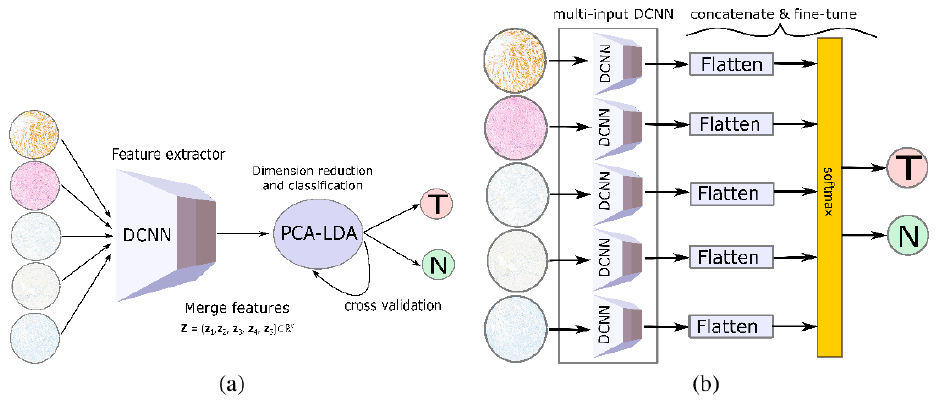
Figure 9. Data fusion approaches using transfer learning strategy. ( a ) Using a pre-trained DCNN as feature extractor prior to classic machine learning. ( b ) Multi-input DCNN with pre-trained network used as feature-extraction layers. Reprinted with permission from reference [62], 2021, Pradhan et al.